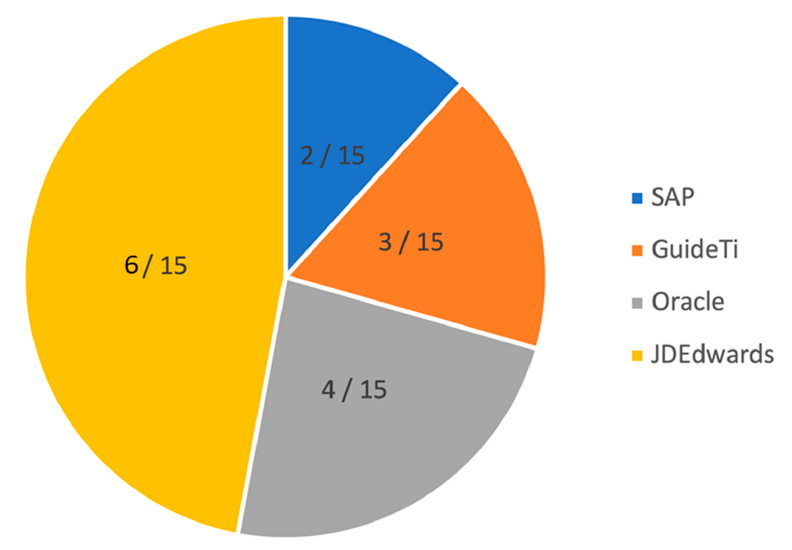
Figure 7. CMMS by number of mentions. Screenshots of a work order as defined in JDEdwards and GuideTi are presented in Figures A1 and A2, respectively. Following, Table 5 records participants’ most frequent feedback on the used CMMS. Table 5. Participants’ feedback on